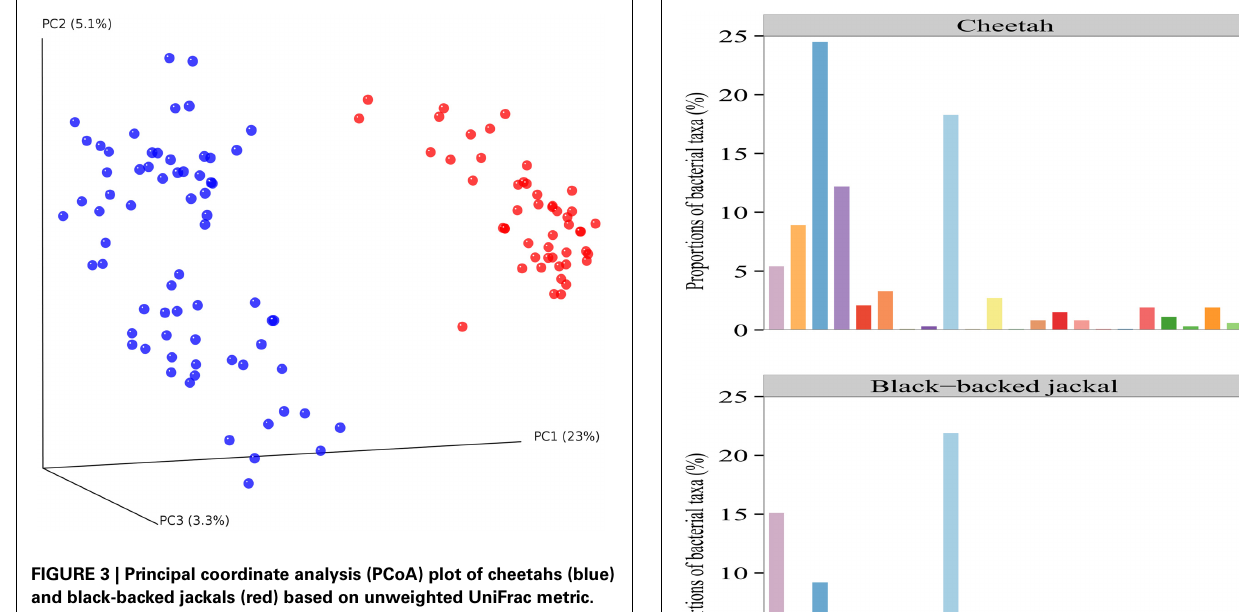
species [ Figure 3 ; PERMANOVA: R 2 = 0 . 74, F (1 , 116) = 337,02, p < 0 . 001]. The three axes of the three-dimensional PCoA plot based on UniFrac distance measures explained more than 30% of the variation in the data set. The Bray-Curtis distance matrix revealed that cheetahs were less similar among each other than black-backed jackals (mean Bray-Curtis similarity indices for cheetahs = 34, for black-backed jackals = 40).